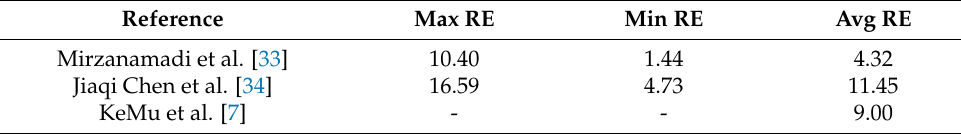
Table 3. Initial range of each random